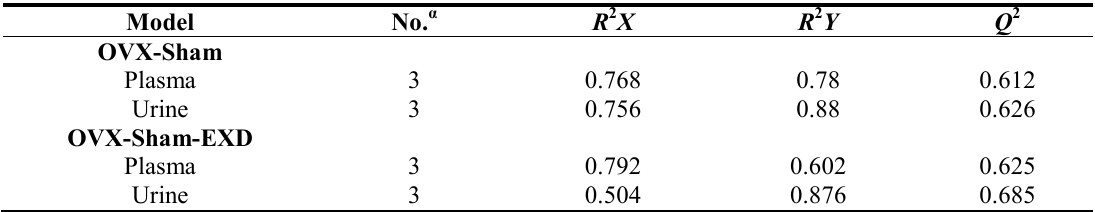
Table 2. Summary of the parameters for assessing quality of the partial least squares discriminant analysis (PLS-DA) model.